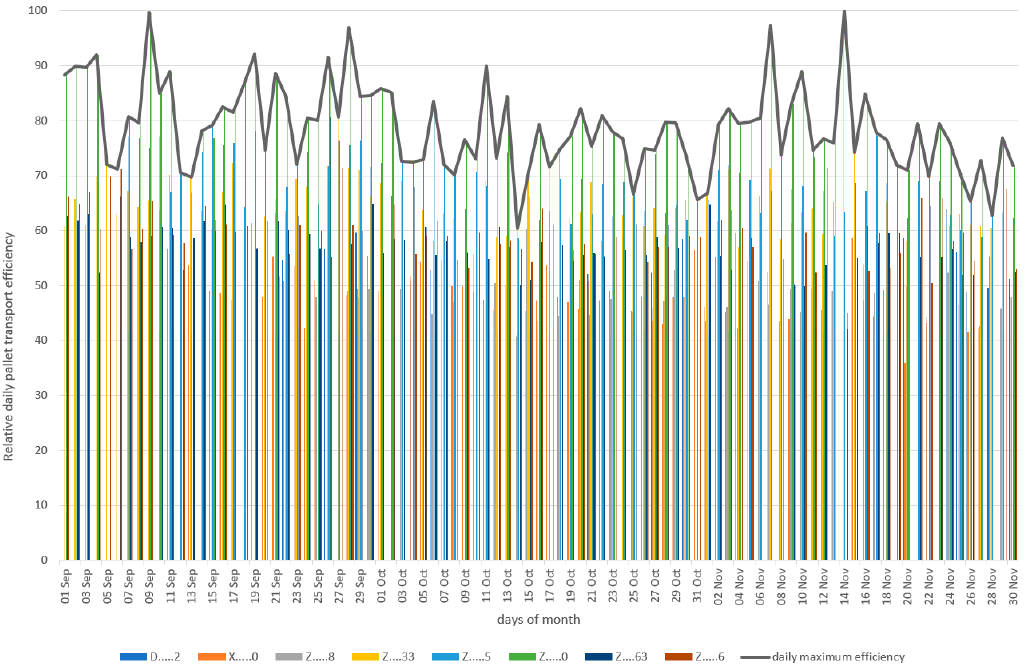
Figure 11. Relative daily efficiency—the weighted ratio of the number of transported pallets to the amount of fuel consumed over a distance of 100 km, expressed in [%], where the reference is the most effective day from a given 3-month period.